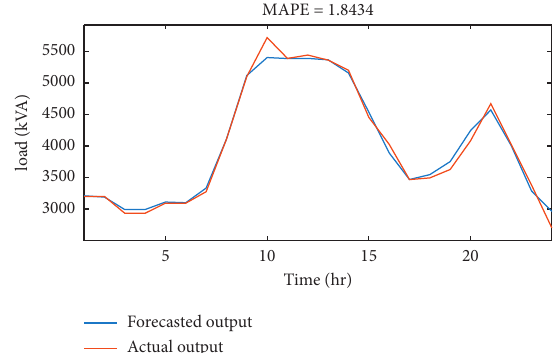
Figure 15: The Fuzzy-PSO prediction of Eidaldeha load.